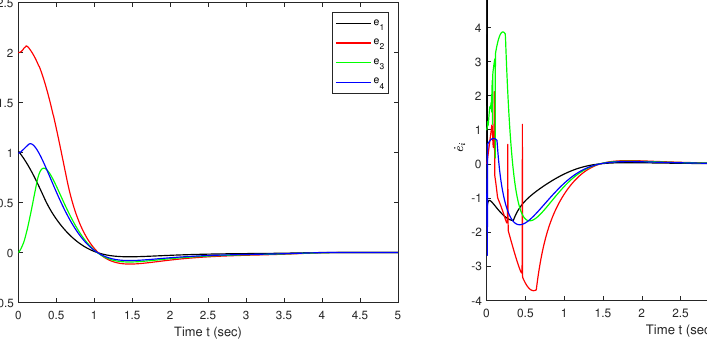
Figure 4. Tracking errors e i and ˙ e i , i = 1,2,3,4.